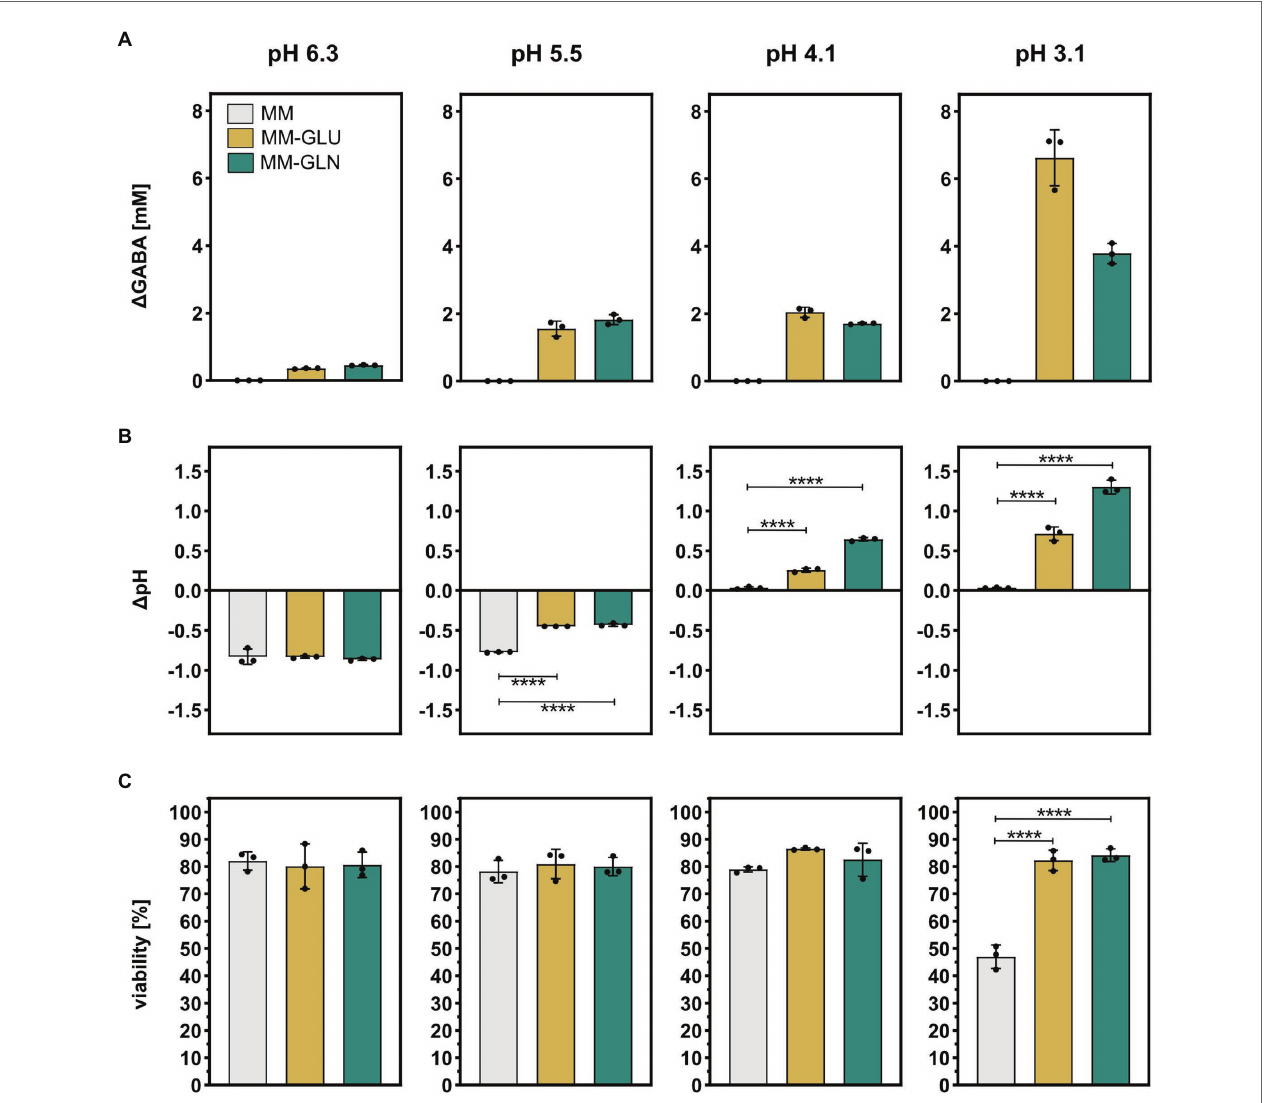
FIGURE 5 | Effect of acid stress on GABA production, pH modulation, and cell viability in B. thetaiotaomicron DSM 2079. B. thetaiotaomicron DSM 2079 cells were incubated in MM, MM-Glu, or MM-Gln at pH 6.3, 5.5, 4.1, or 3.1 for 1 h ( n = 3). (A) Concentration of GABA, (B) change in pH, and (C) viability are displayed. Dots represent replicates; bars represent SD. Significances were calculated by one-way ANOVA test, including Tukey’s test: **** p < 0.0001. Data on glucose consumption and metabolic acid production are available in Supplementary Table S3